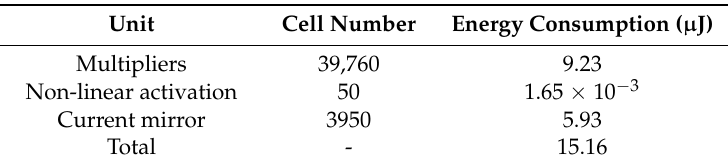
Table 2. Energy consumption of each part in MLP.